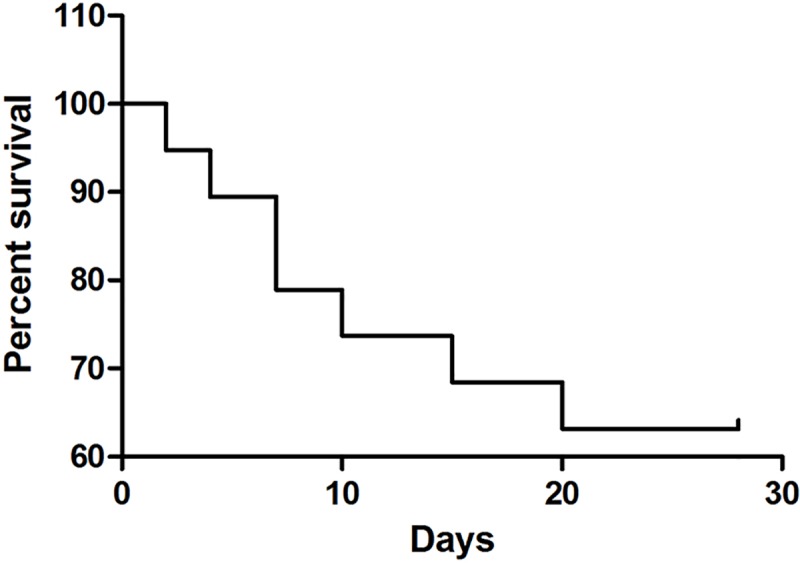
Survival analysis of the sick group (G1) after a 28-day monitoring period.